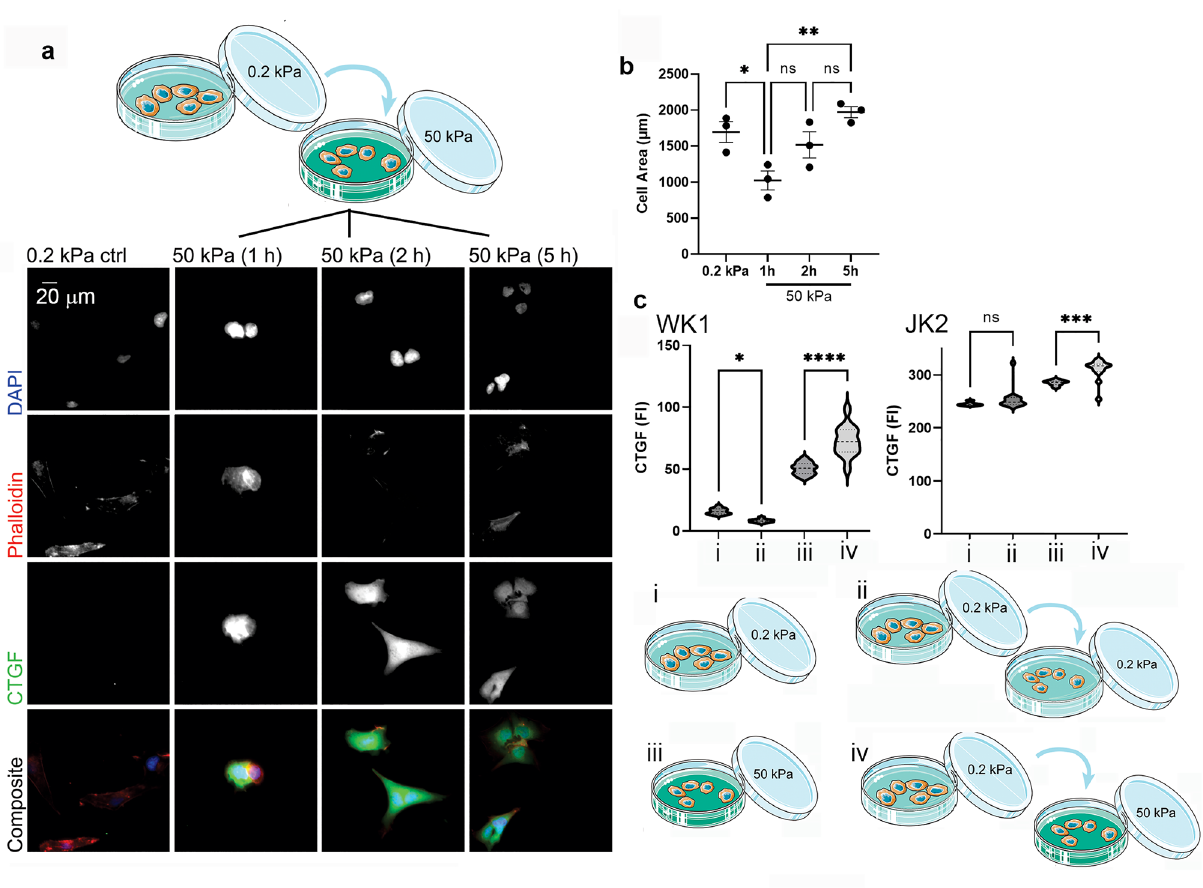
Figure 3. Connective tissue growth factor expression is rapidly induced by a stiff tissue environment. ( a ) WK1 cells grown on 0.2 kPa gels (ctrl) or grown on 0.2 kPa gels, then detached and replated onto 50 kPa gels as per the schematic and for the indicated times. Cells were immunostained with anti-CTGF antibodies, DAPI to detect nuclei and phalloidin to detect F-actin. Scale bar = 20 µm. ( b ) Mean surface area of cells cultured as shown in ( a ). Each data point represents the average from 3 biological repetitions (n = 35 for each respective group). Error bars indicate ± SEM. Symbols denote statistical significance: **p < 0.01; *p < 0.05; NS = not significant (p < 0.05); One-way ANOVA with Tukey’s post-comparison test. ( c ) Plots show fluorescence intensity of CTGF. WK1 and JK2 cells were treated as follows: (i) incubated on 0.2 kPa PAGs, (ii) incubated for 24 h on 0.2 kPa PAGs then transferred to fresh 0.2 kPa PAGs for 1 h, (iii) incubated on 50 kPa PAGs and (iv) incubated for 24 h on 0.2 kPa PAGs then transferred to 50 kPa PAGs for 1 h. Graphs show data pooled from ≥ 13 fields of view. Error bars indicate ± SEM. Symbols denote statistical significance: ****p < 0.0001; ***p < 0.001; *p < 0.05; Ns = not significant (p < 0.05); One-way ANOVA with Tukey’s post-comparison